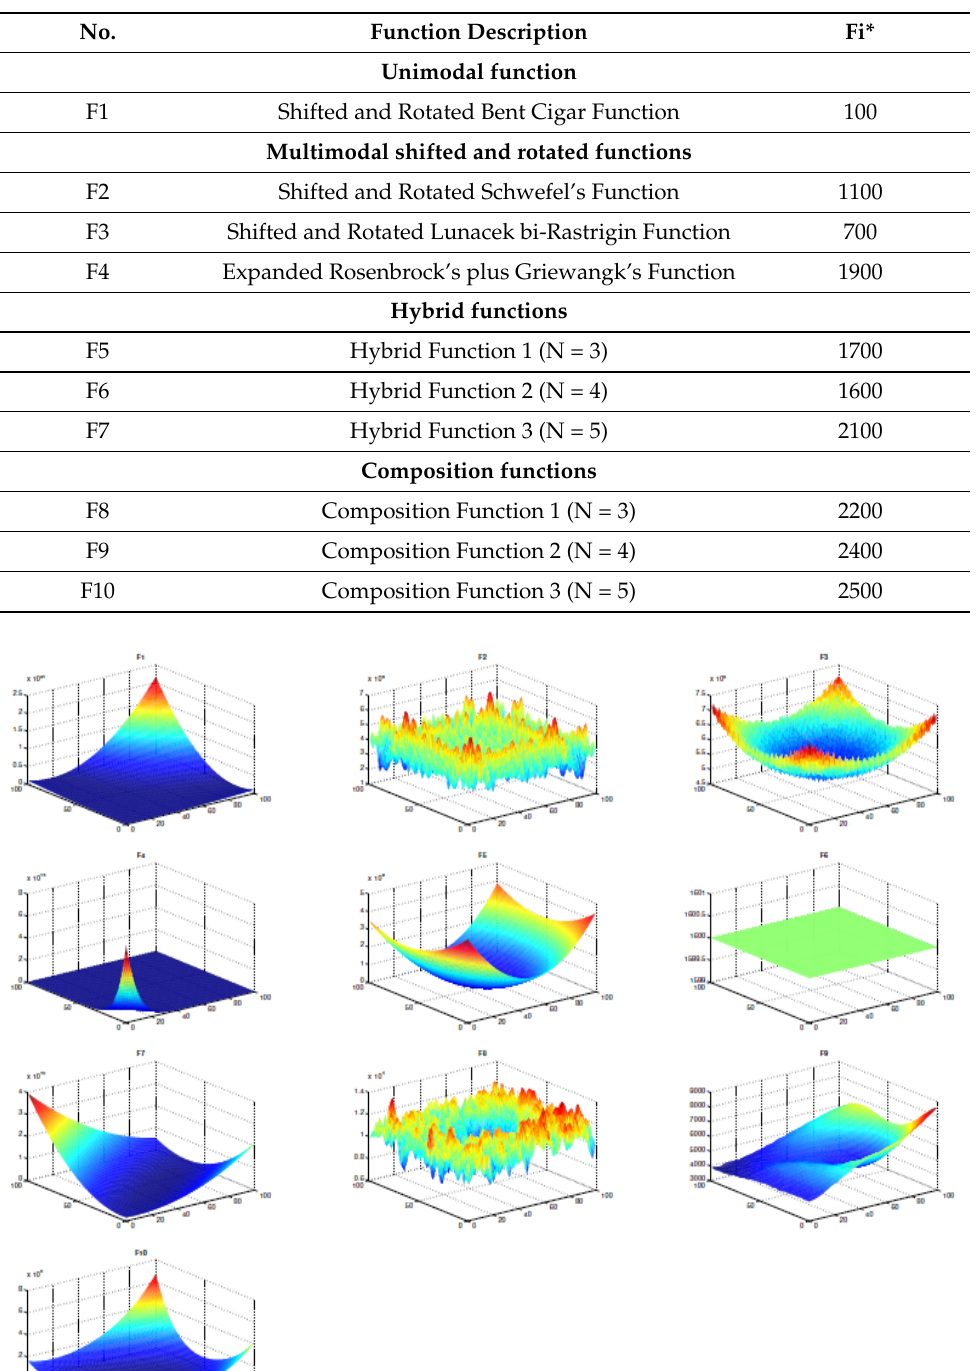
Table 1. CEC’2020 benchmark functions.